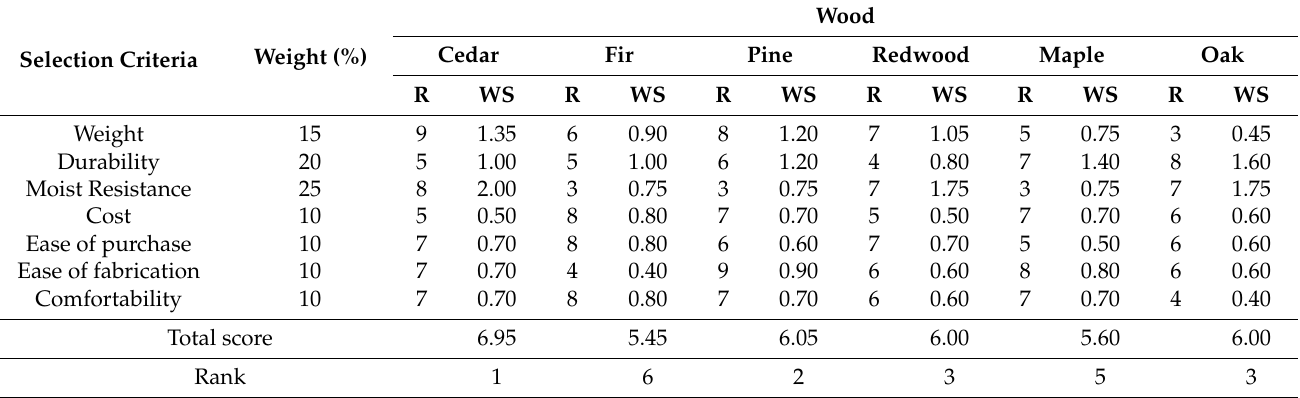
Table 6. Scoring of wood